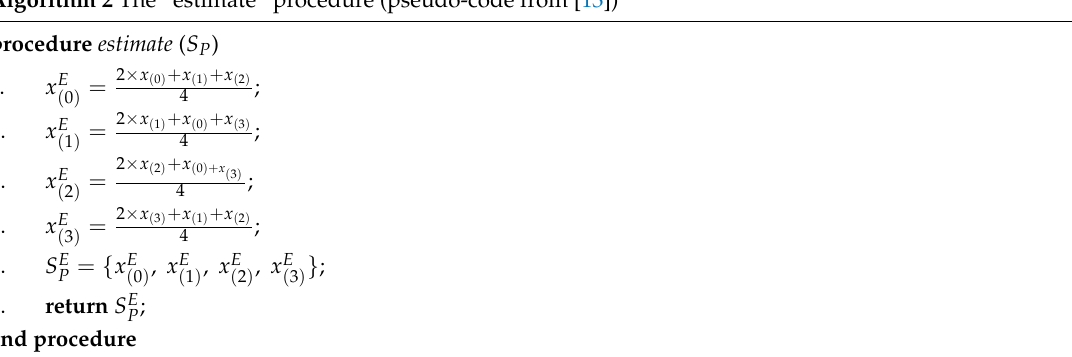
Algorithm 2 The “estimate” procedure (pseudo-code from [13])